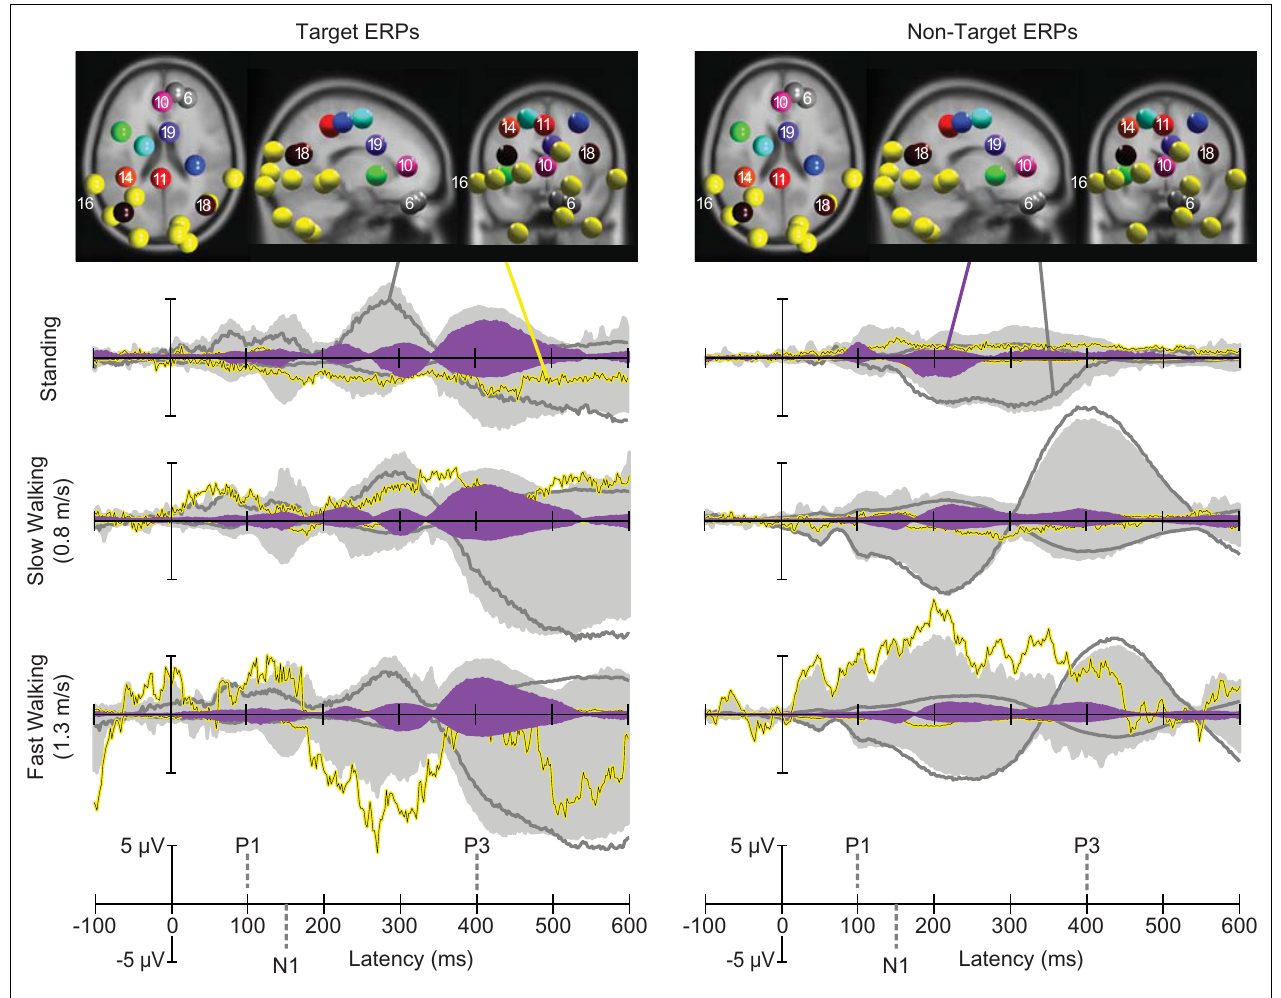
envelopes of one representative neck muscle cluster (Cluster 16, yellow traces) and a representative eye movement cluster (Cluster 6, dark gray traces). Filled purple envelopes show the back-projected contribution of one IC cluster (19) with equivalent dipoles in or near anterior cingulate cortex. Left column: visual target stimulus responses in the three movement conditions. Right column: non-target stimulus